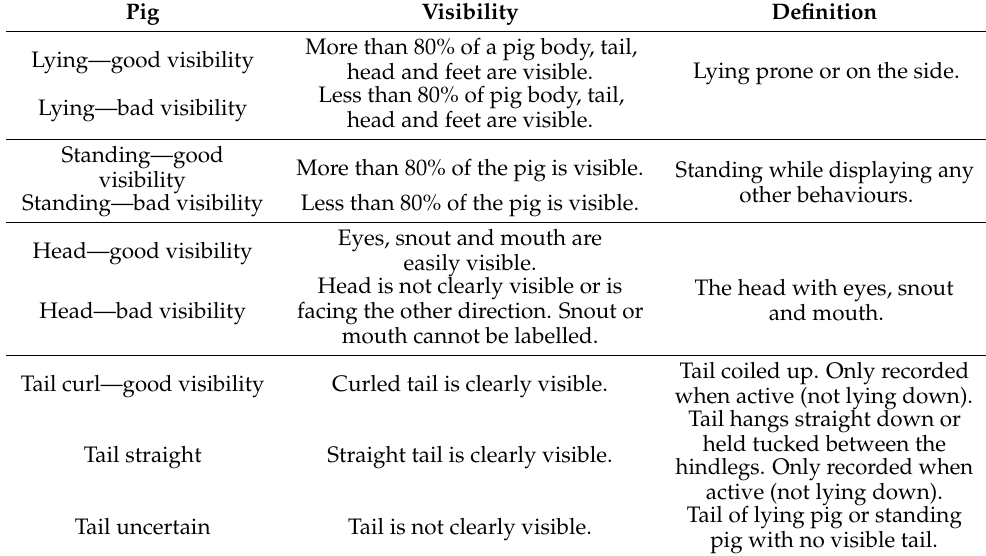
Table 1. Description and definition of individual pig labelling in the first part of the